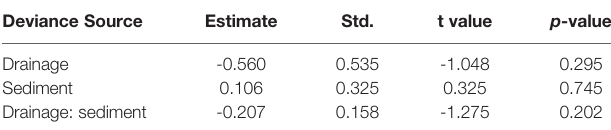
TABLE 3 | Con fi dents of the generalized linear model (GLM) for examining the effects of drainage and sediment on seedling survival in the mesocosm experiment.